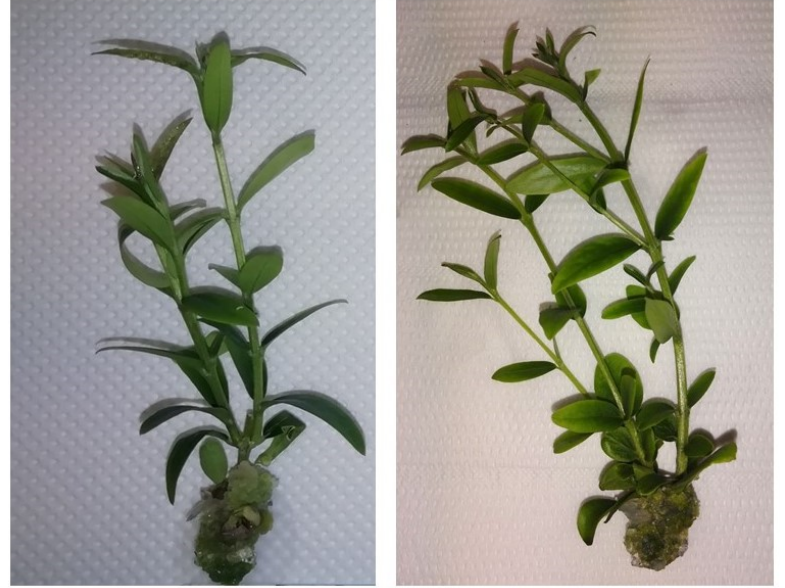
Figure 2. Olive explants grown in Z4 n.o. (zeatin 4 mg L − 1 , neem oil 0.1 mL L − 1 ) ( right ) and Z4 (zeatin 4 mg L − 1 , neem oil 0 mL L − 1 ) ( left ) substrates .